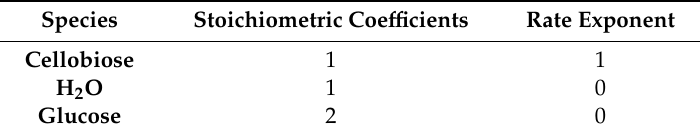
Table 2. Stoichiometric coe ffi cient and rate exponent.